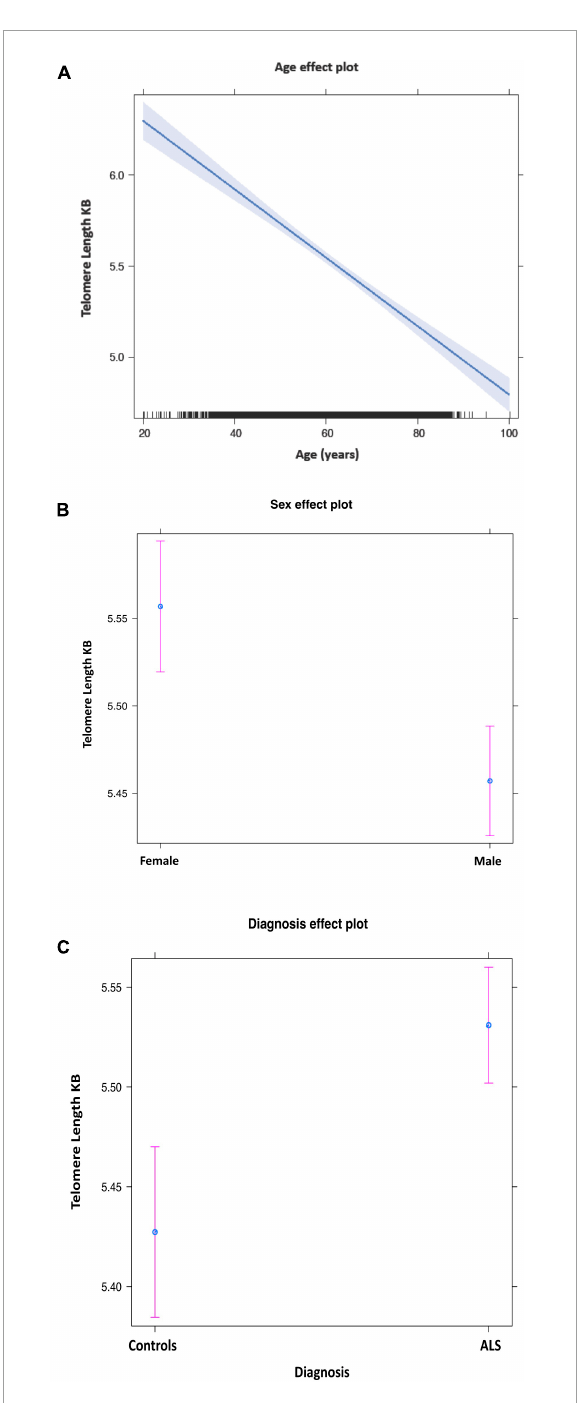
FIGURE1 Mean telomere length by age (A) , sex (B) , and disease status (C) . Purple bars indicate 95% confidence intervals.